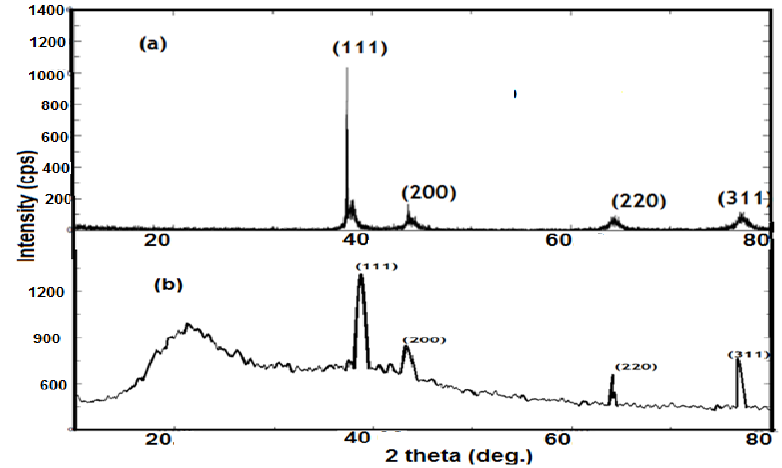
Figure 3. XRD patterns of ( a ) Ag NPs and ( b ) silver AMPS/NIPAm hybrid